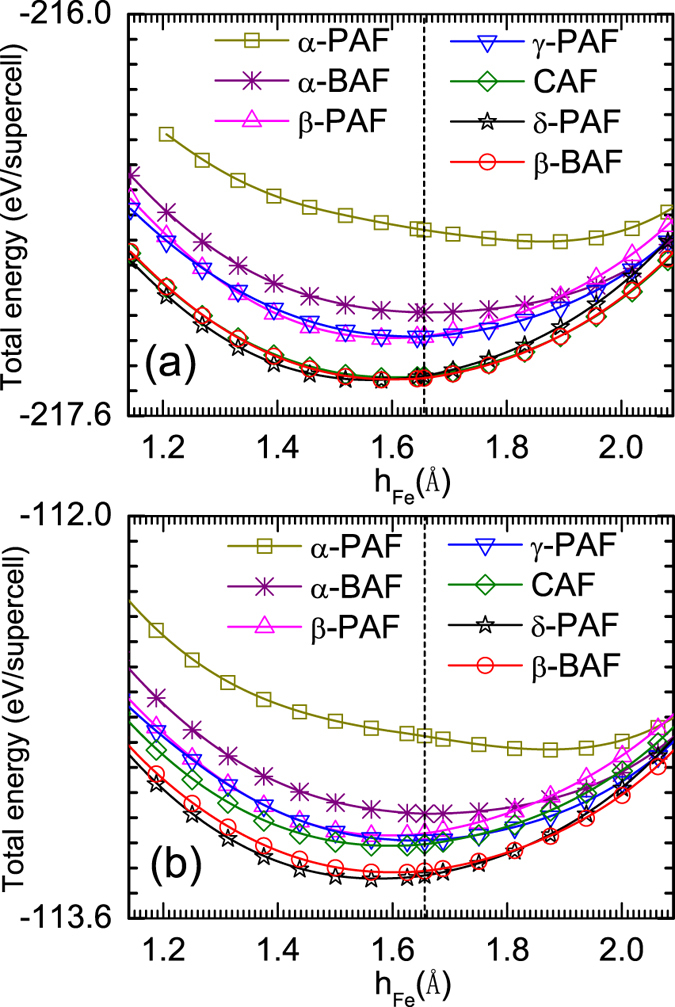
Total energies of different magnetically ordered states shown in Fig. 1 as a function of height of interstitial Fe measured from Fe plane in the supercells of Fe17Te16 (a) and Fe9Te8 (b), which corresponds to a stoichiometry of Fe1.0625 Te and Fe1.125Te, respectively.The experimental value of the position of interstitial Fe15 is marked by dashed line.